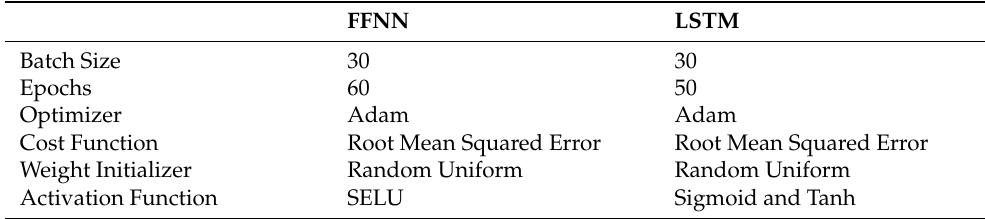
Table 2. Hyperameter values selected after stochastic grid search optimization. FFNN LSTM Batch Size 30 30